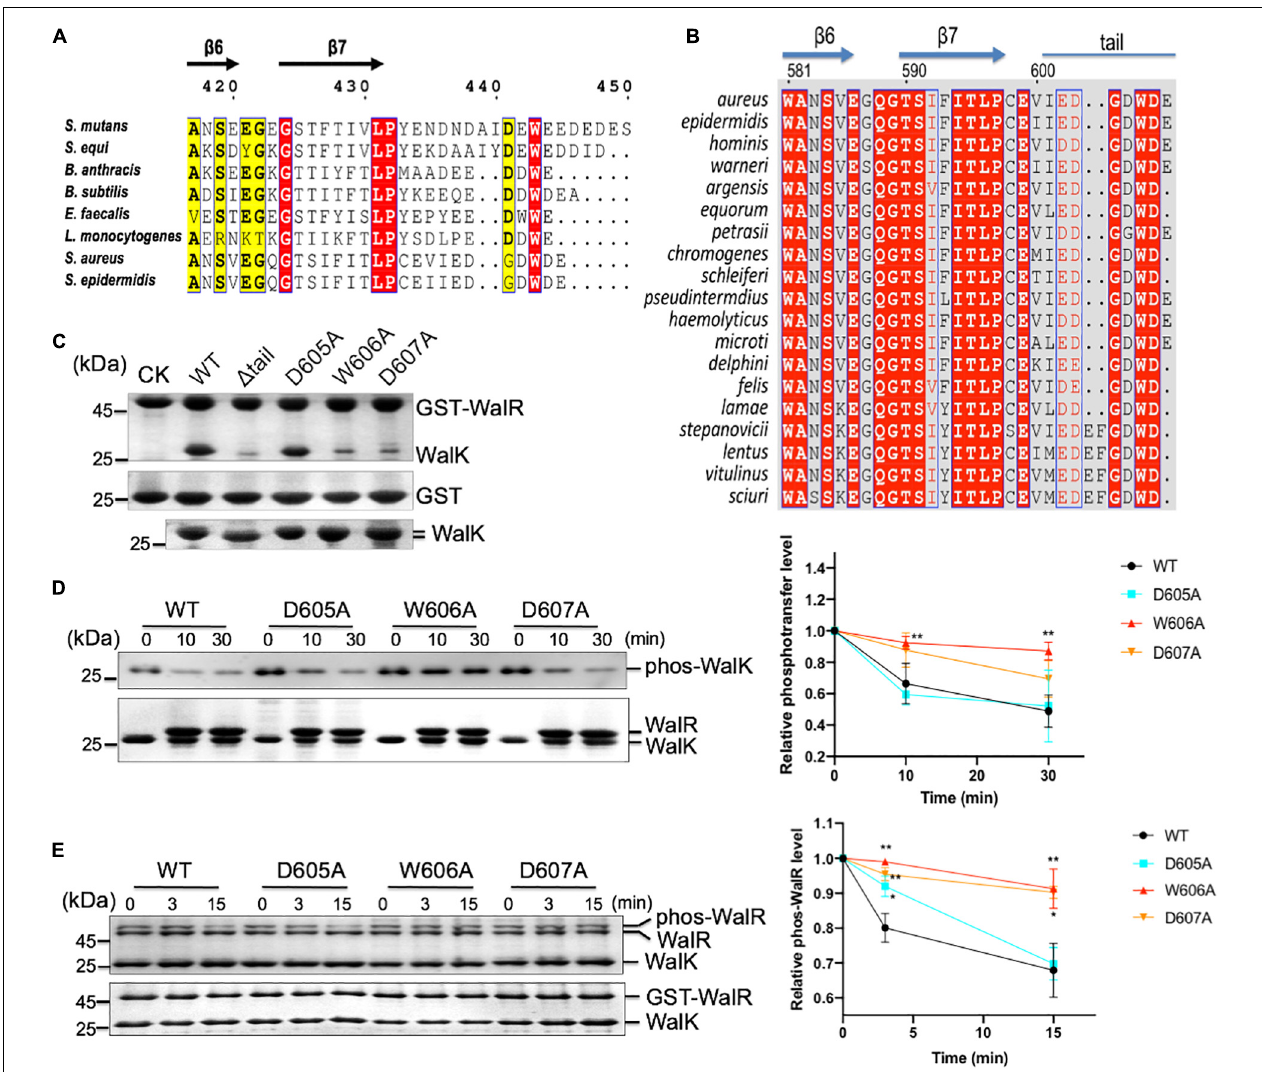
FIGURE 7 | The CTT of WalK is required for S. aureus WalRK interaction and enzymatic activity. (A) Conservation of the WalK CTT across Gram-positive bacteria. Representative sequences of WalK C-termini were aligned and boxed. The residues are numbered according to S. mutans WalK. Completely conserved residues are colored in white in a red background. The less conserved residues are highlighted in yellow. (B) Alignment of staphylococcus WalK tail sequences. Completely conserved residues are shown in white in a red background and boxed in blue. Highly conserved residues are in red in a white background and boxed in blue. Marked on top are protein secondary structures and residue numbers in S. aureus . (C) Mutations in the CTT disrupt WalRK interaction. A GST fusion protein with full-length S. aureus WalR was used to pull-down S. aureus WalK (364–608) WT and mutant derivatives shown in the top panel. As a negative control, GST alone was used to pull down WalK WT and its mutants shown on the center panel. Shown in the bottom panel are 10% levels of WalK proteins used in each lane. CK shows GST-WalR or GST used in the pull-down. (D) Phosphotransferase of WalK (364–608) was disrupted by mutations in the WalK CTT. The phosphotransferase activity was represented by the reduction in WalK phosphorylation relative to T0, the initial phos-WalK. After the addition of WalR, the mixtures were incubated for the indicated time and stopped by the addition of SDS-loading buffer. Loading controls are shown in the bottom gel. The enzymatic activity was quantified shown below. (E) Phosphatase of WalK (364–608) was disrupted by mutations in the WalK CTT. Phos-tag gel is shown in the top, and a regular SDS-PAGE below shows the total protein used. The phosphatase activity was quantified by the reduction in the phos-WalR relative to the amount of T0, the initial phos-WalR. The reactions were incubated for the indicated time and stopped by the addition of SDS-loading buffer. Data presented are means ± standard deviations (error bars) for three independent experiments. Student’s t -tests were used to compare mutants to WT at each time point (** p < 0.005 and * p <